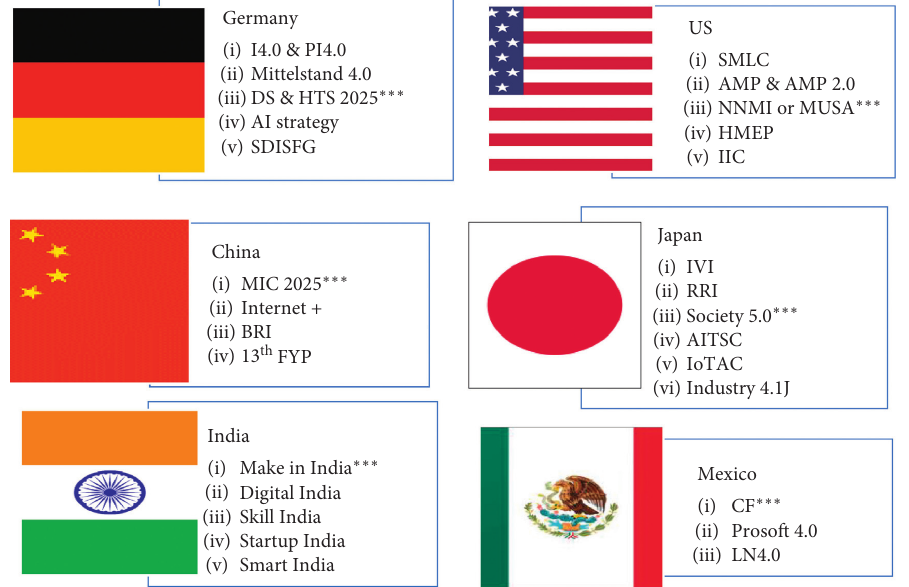
Figure 3: Industry 4.0 initiatives in the six selected